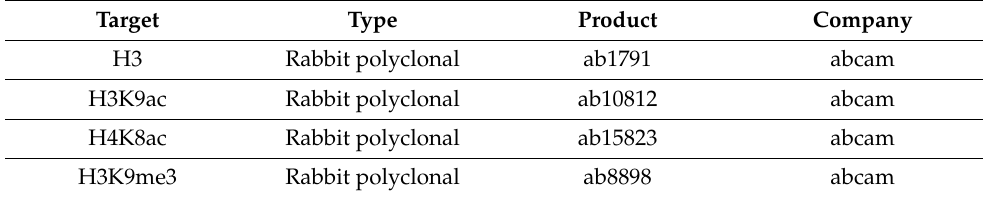
Table 3. Antibodies used for